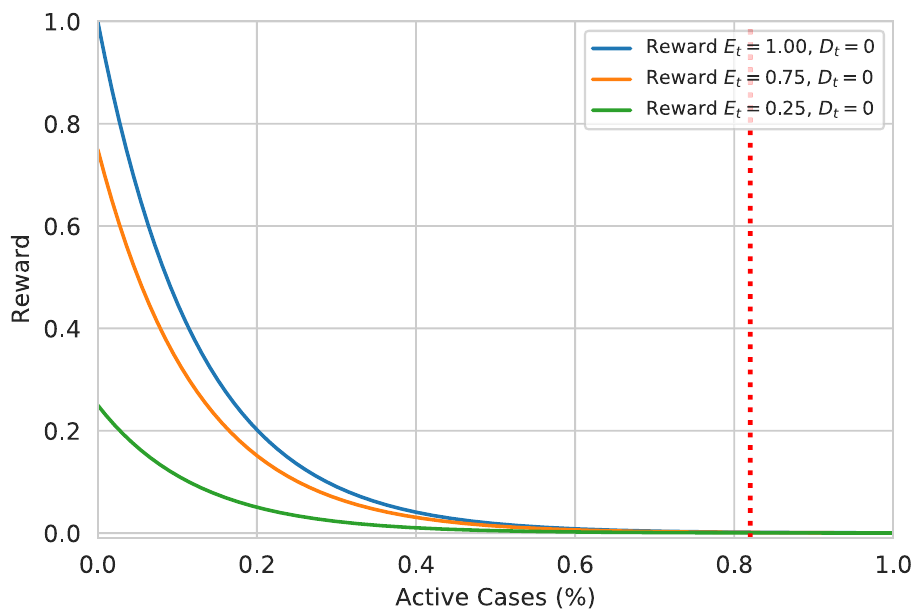
Figure 5. The graph illustrates the decay of reward value concerning the increase in the percentage of active cases (neglecting the cumulative death cases D t = 0). The value of E t being 1, 0.75, and 0.25 approximately represents the level-0, level-1, and level-2 movement restrictions. After crossing 0.82% of active cases, the reward of all the different restrictions falls to